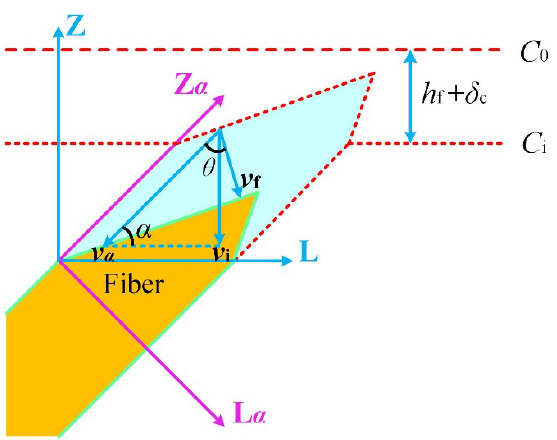
Figure 3. Schematic diagram of fiber morphology recession during steady-state